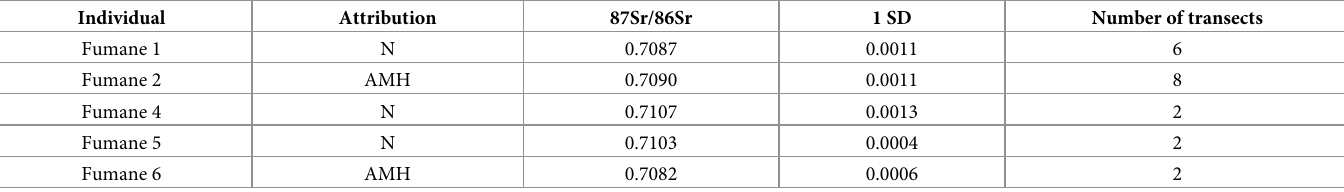
Table 3 in S1 File . The average difference in values for the modern human and Neanderthal Table 2. Strontium isotope data for hominin teeth from Fumane